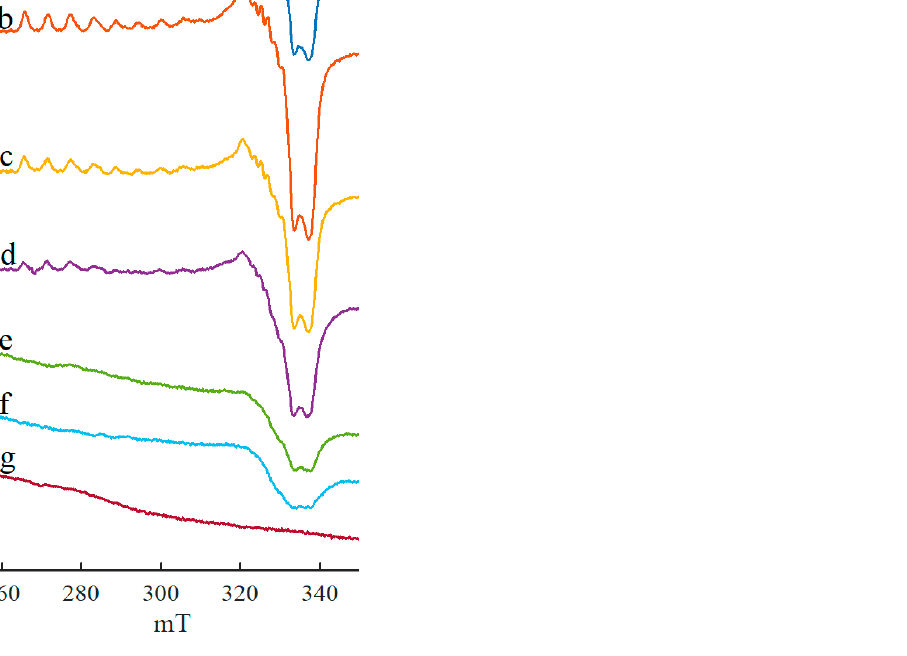
Figure 3. Time dependence of EPR spectra of the catalytic system formed on the basis of Co(acac) 2 – AlEt 3 in mesitylene in an argon atmosphere under otherwise equal time conditions: ( a ) 0.1–1 min, ( b ) 5–15 min, ( c ) 15–25 min, ( d ) 25–45 min, ( e ) 45–80 min, ( f ) 80–160 min, ( g ) 200 min. Spectrum ( a ) was taken from [69].